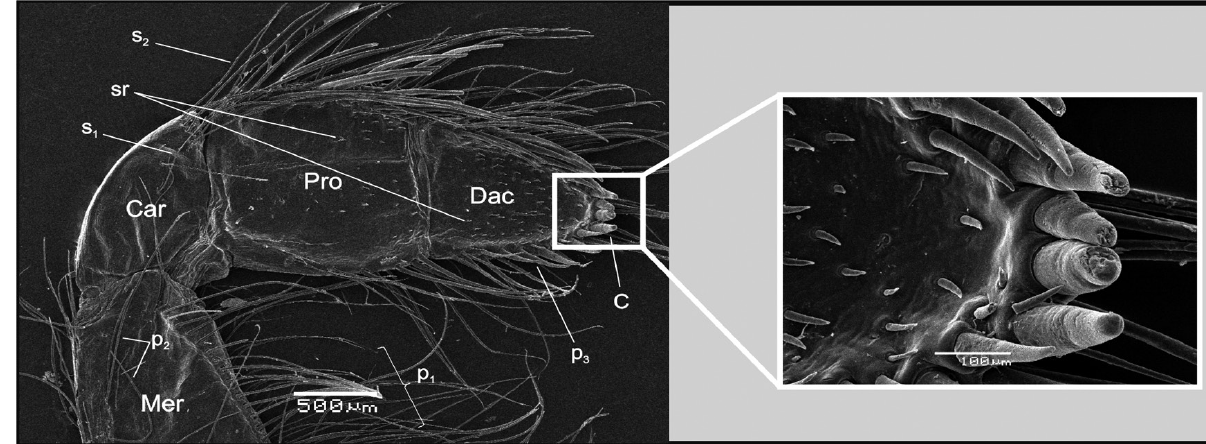
Fig. 1. – Neohelice granulata . SEM photomicrographs of maxilliped 2. Right, detail of cuspidate setae at the distal part of the dactylus show- ing signs of worn. Mer, merus; Car, carpus; Pro, propodus; Dac, dactylus; p simple setae; s , long simple setae, sr, small and robust setae; p 2